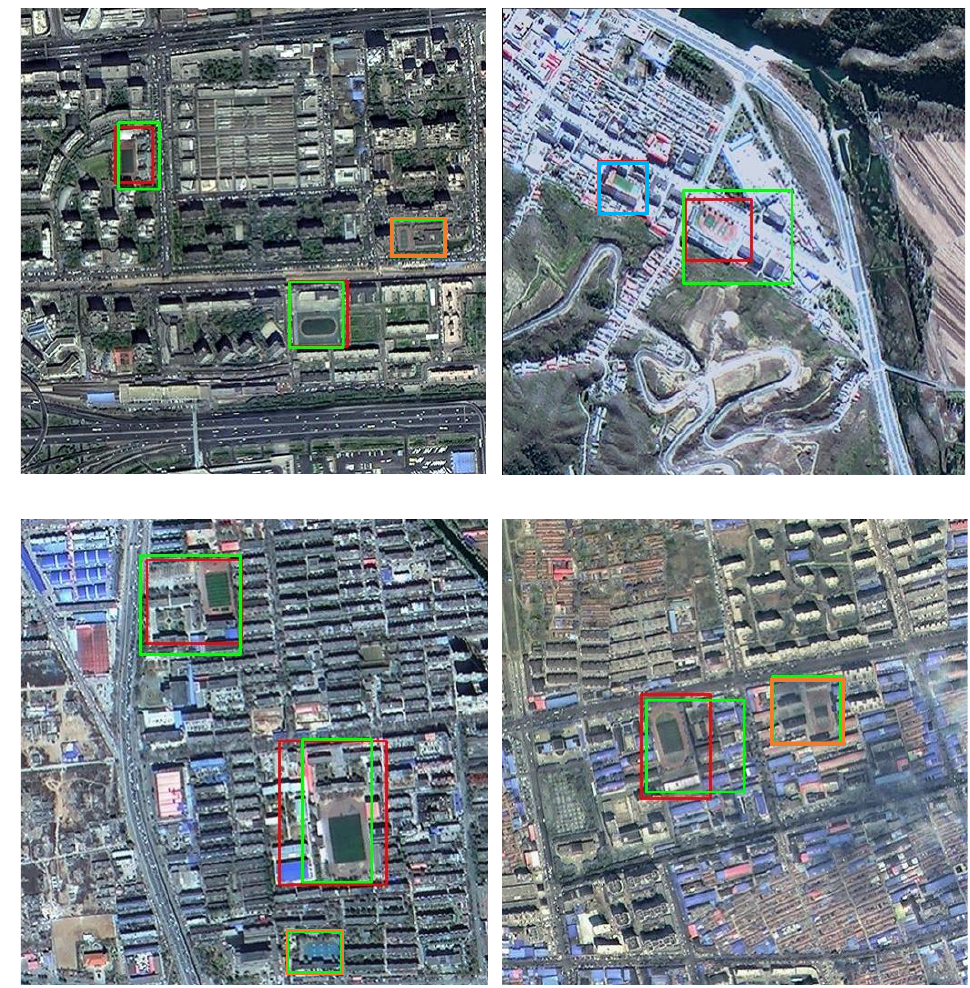
Figure 10. Some detection results of the proposed method on the test set. The false positives and false negatives are plotted in blue and orange,